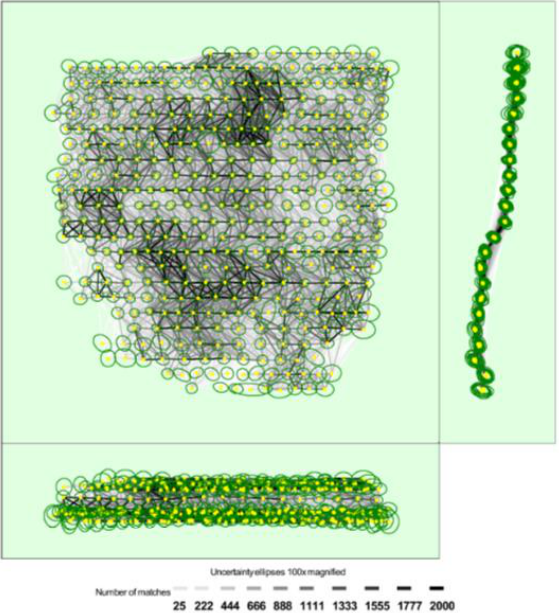
Figure 4. Approved points and camera uncertainty of the point cloud (Feb 2, 18)